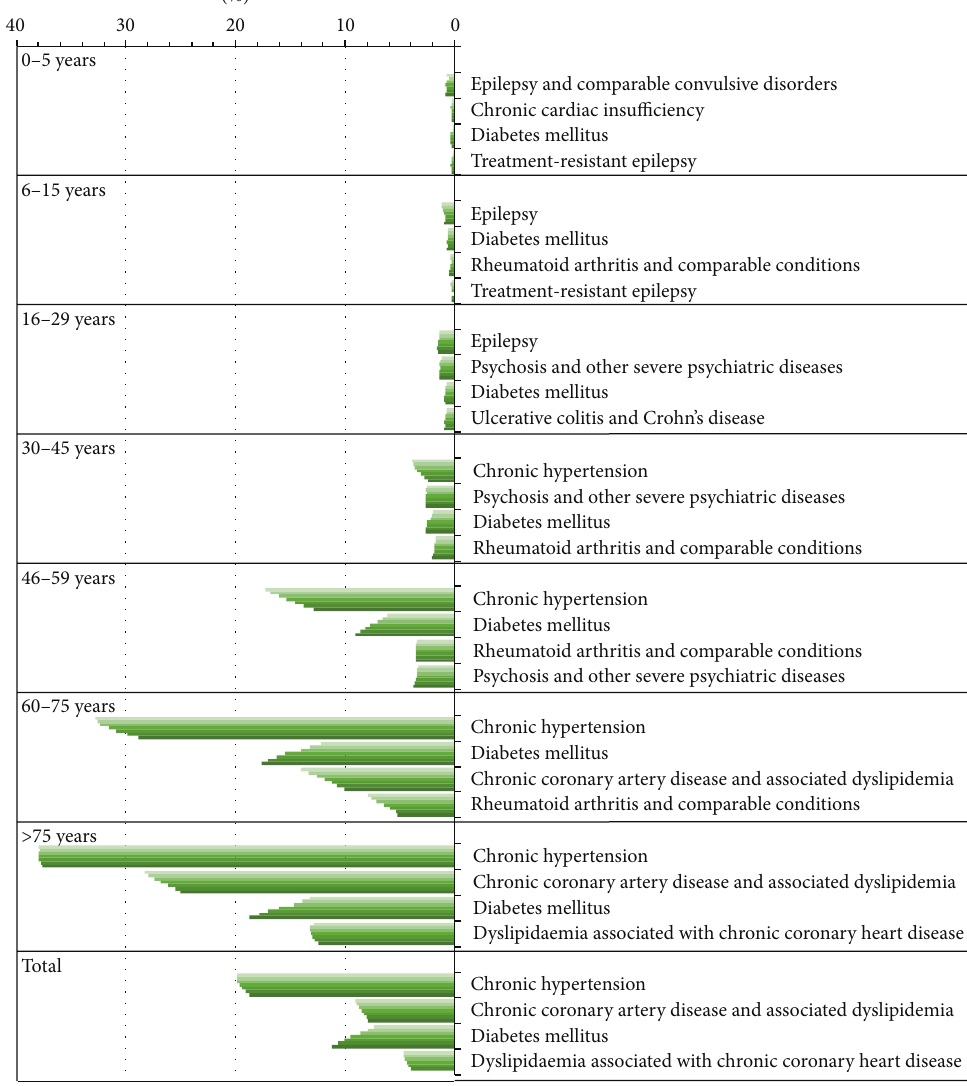
Figure 2: Four most common comorbidities among patients with persistent asthma in different age groups according to Social Insurance Institution register data from 2008 to 2014 (from top and light grey to bottom and dark green of a bar).